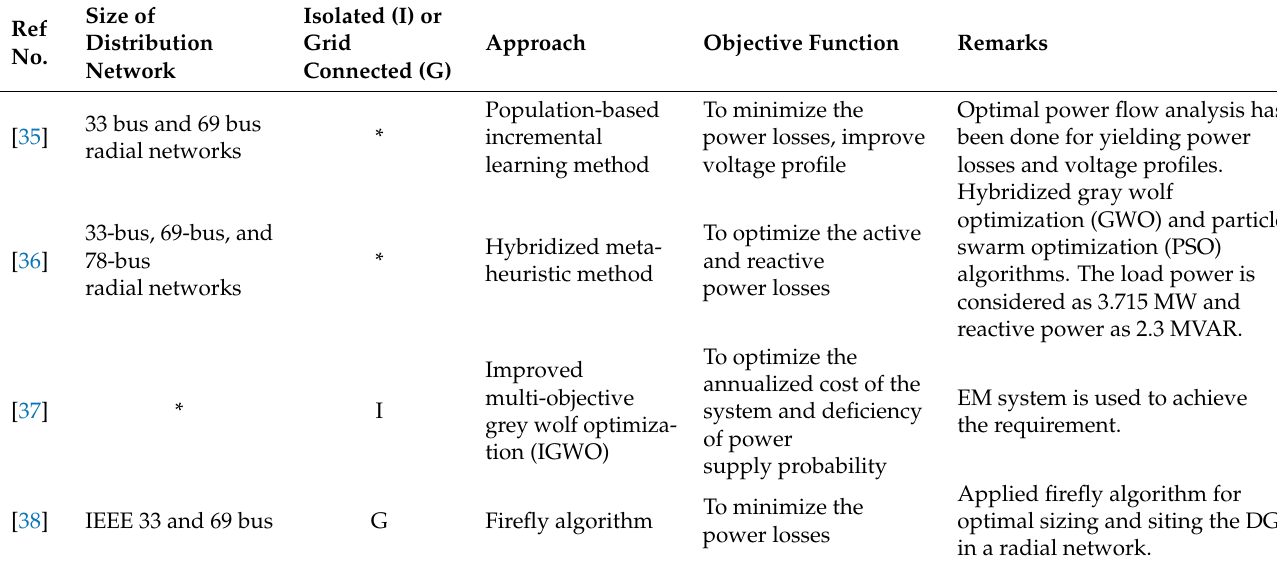
Table 2. Optimal scheduling of DERs in a